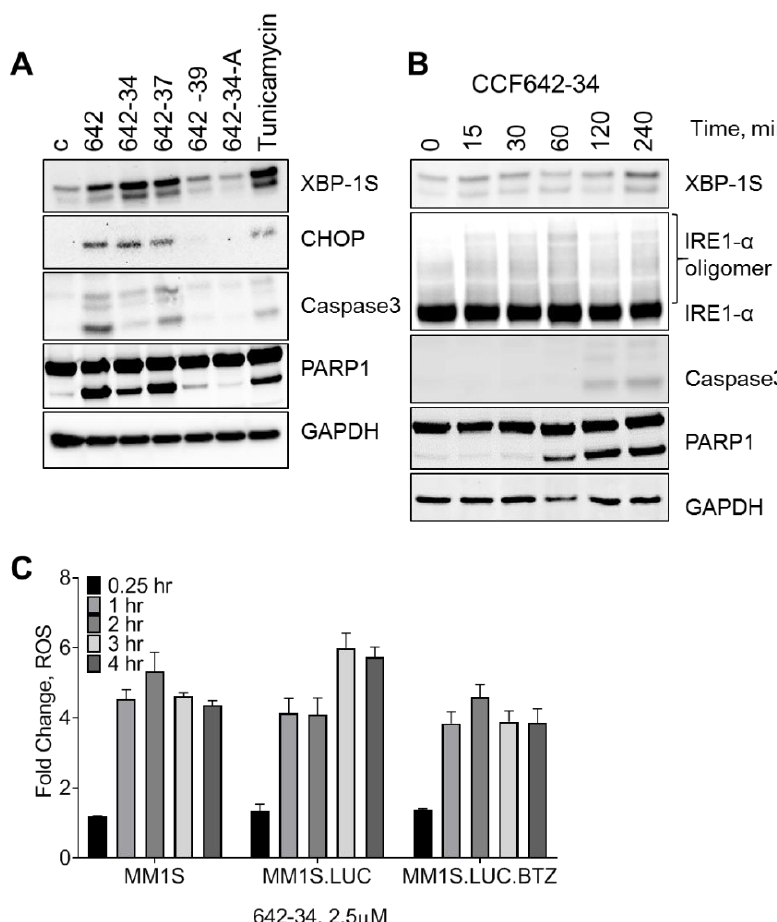
Figure 4. PDIA1 inhibition by CCF642 analogues induce acute endoplasmic reticulum (ER) stress response and lead to apoptosis. Multiple myeloma cells (MM1.S) were treated with 3 µ M of CCF642, -34, -37, -39, -34-A, and Tunicamycin (as a control). The status of ER sensors (XBP-1S, IRE1 α oligomerization, and induction of C/EBP homology protein (CHOP)) along with apoptosis markers (cleaved caspase 3 and PARP1) were monitored. ( A ) MM1.S cells were treated for 4 h with CCF642 and its indicated analogues. ( B ) MM1.S cells were treated with CCF642-34 in a time course. ( C ) MM1.S, MM1.S.luc, and BTZ-resistant MM1.S.luc cells were stained with the H2DCFDA ROS detection and then treated with 2.5 µ M CCF642-34 up to 4